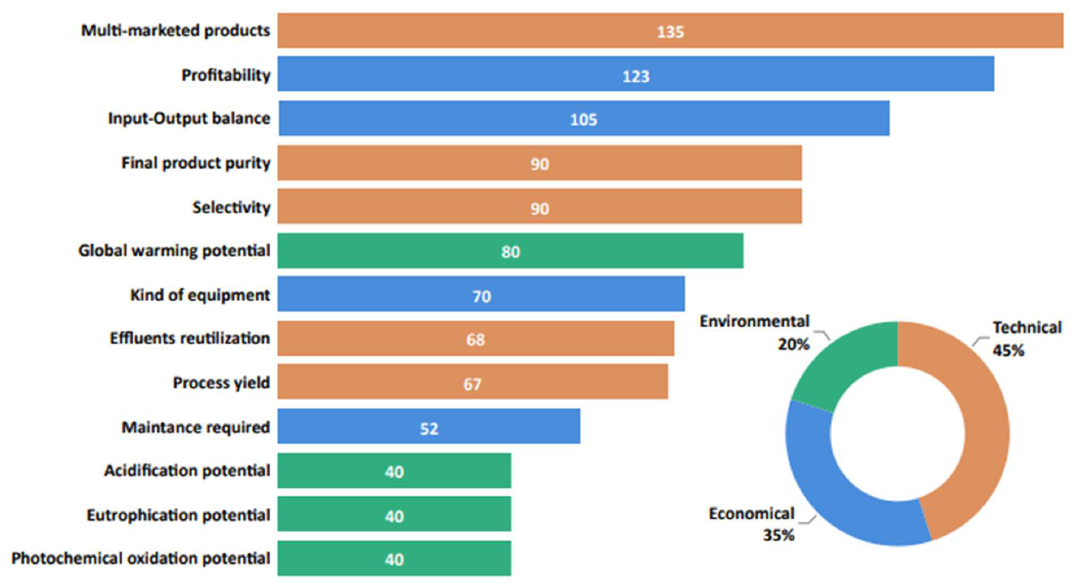
Figure 2. Sustainability Potential Units distribution among the different categories and components.